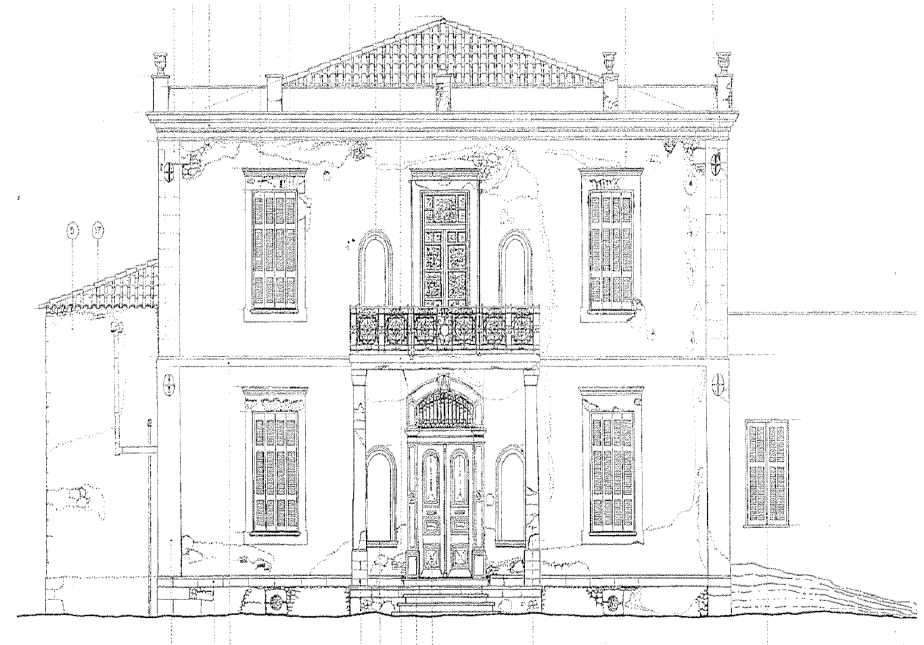
Figure 47. Front view of the Palace.